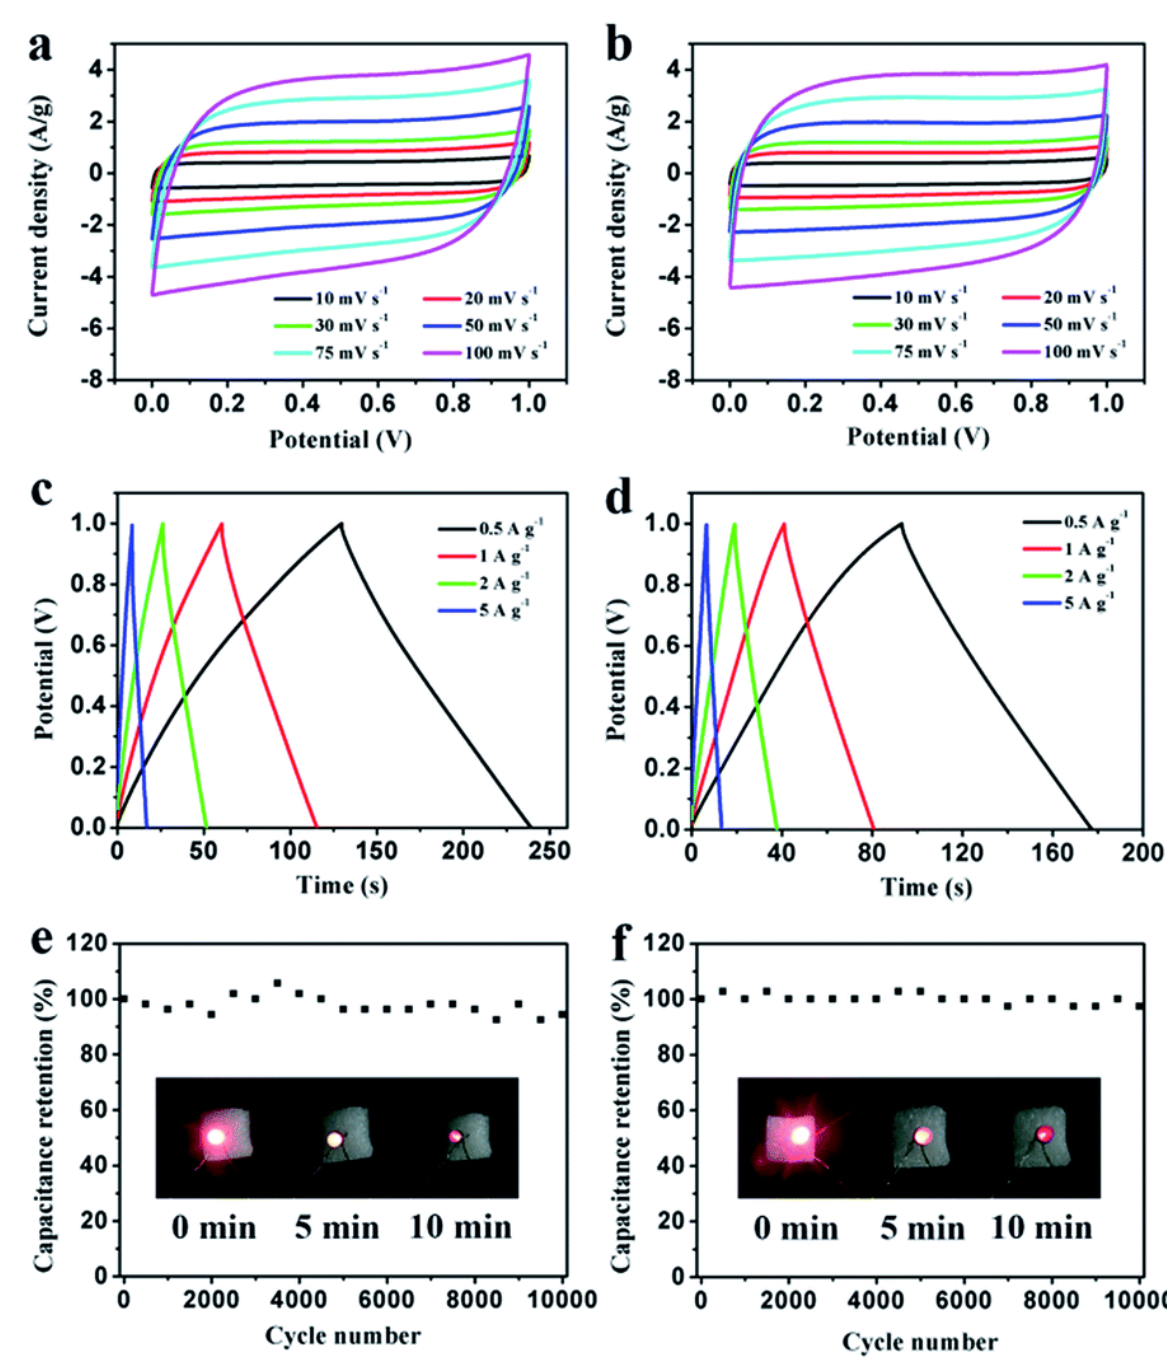
Figure 15. Electrochemical performance of PEG-40% symmetrical supercapacitors in 1 M H 2 SO 4 and 2 M KOH, respectively. ( a , b ) CV curves at different scanning rates; ( c , d ) GCD curves at different current densities; ( e , f ) cycling stability at a 1 A/g. Adapted from reference [91]. This article is an